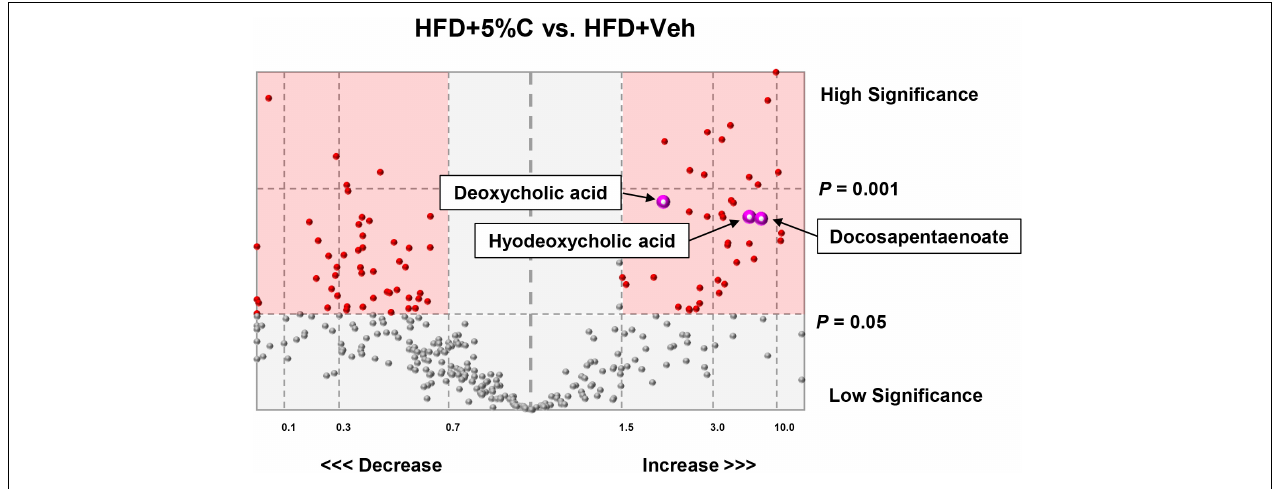
FIGURE 4 | Metabolomic analysis of cecal contents. A volcano plot identified 42 metabolites, including deoxycholic acid, hyodeoxycholic acid, and docosapentaenoate, that were significantly increased in the HFD + 5%C group as compared with the HFD + Veh group (right pink